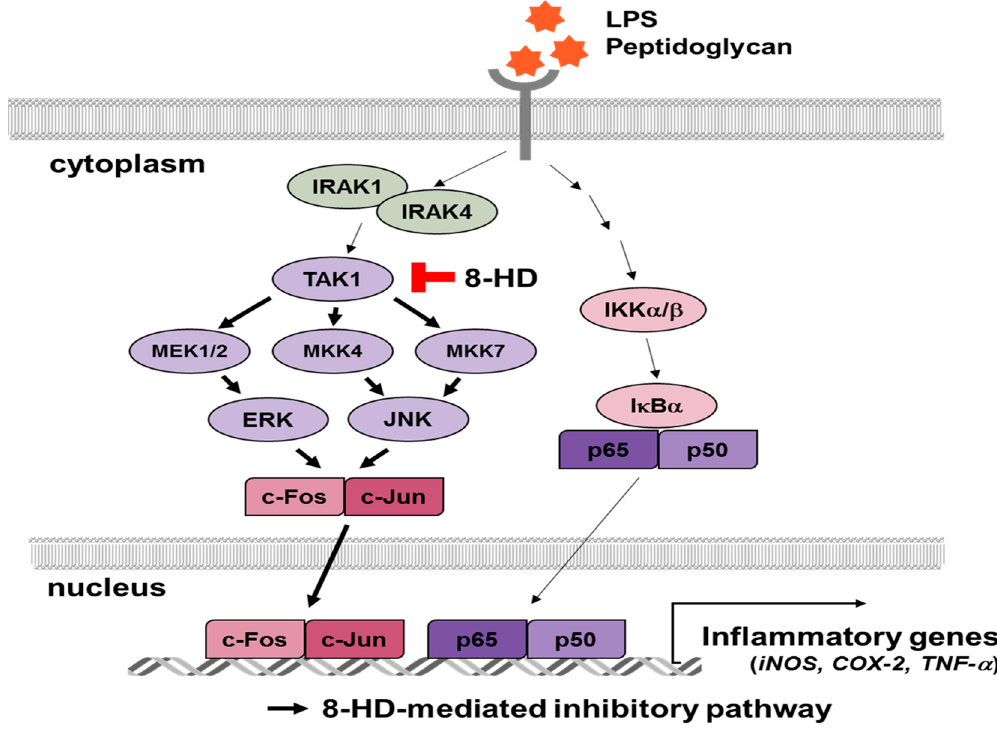
Figure 6. The regulatory effects of 8-HD on inflammatory signaling pathways. In the AP-1 signaling pathway, 8-HD suppresses the activity of TAK1, and subsequently, the transcriptional activity of c-Fos is also inhibited.